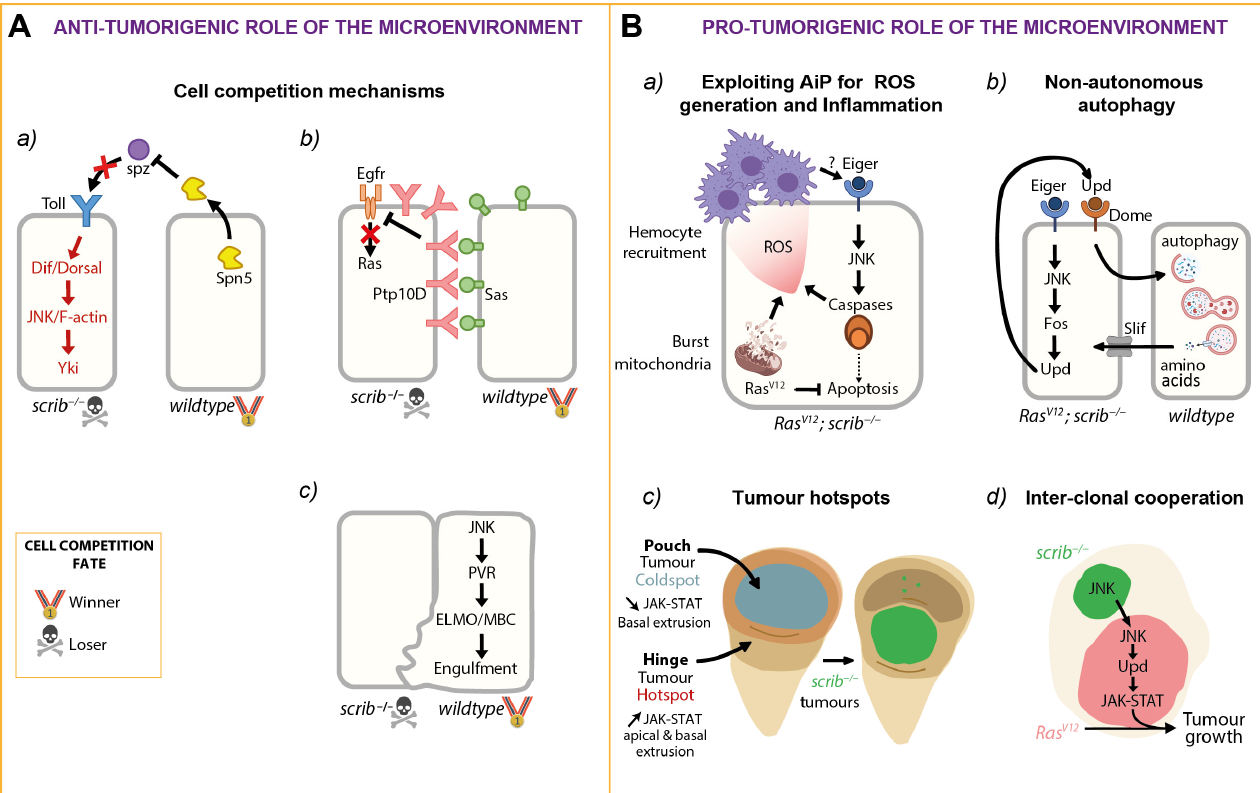
Figure 3. Local microenvironment interactions can act as suppressors or be exploited for tumor growth. ( A ) Anti-tumorigenic role of the microenvironment. scrib − / − tumors are actively eliminated by the neighboring cells through cell competition. Several mechanisms are put in place by the winner cells, the microenvironment, to restrict the growth and remove the loser cells, the scrib − / − tumors. ( a ) The expression of an inhibitor of the toll ligand Spz, Spn5, is critical in the microenvironment to maintain the loser status of scrib − / − tumors. Upon non-autonomous loss of spn5, Toll signaling, together with JNK and high F-actin levels, can elevate yki activity, an inducer of the winner status (shown in red). ( b ) Upon tumorigenesis, wt cells communicate with the tumor cells through the Sas-Ptp10D signaling axis to inhibit Egfr-Ras signaling, a pathway that can potently cooperate with polarity deficiency for malignancy. ( c ) Activation of JNK in the wt cells activates an engulfment program through PVR-ELMO/MBC which leads to the entosis of the scrib − / − tumors and their death. ( B ) Pro-tumorigenic role of the microenvironment. In a cooperative Ras V12 ; scrib − / − scenario, the microenvironment is exploited to fuel tumor growth. ( a ) Caspase apoptotic induction is inhibited by Ras V12 ; however, apoptotic-independent functions still remain active. Ras V12 ; scrib − / − tumors exploit the mechanism behind apoptosis induced proliferation. Caspases, and potentially impaired mitochondria, can induce high levels of ROS, which triggers hemocyte recruitment. This mounts an inflammatory response that leads to higher JNK levels. ( b ) NAA is induced in the wt cells surrounding Ras V12 ; scrib − / − tumors, through tumor autonomous JNK and the autocrine activation of JAK-STAT through Upd and Dome. Downregulation of the transporter slif in Ras V12 ; dlg − / − showed that these tumors are dependent on exogenous nutrient sources, potentially released from the neighboring wt cells through NAA. ( c ) Areas that are nurturing or hindering for tumor growth, termed tumor “hotspots” and “coldspots”, respectively, have been identified in the wing disc. The tumor hotspot, which is in the wing disc hinge, was found to have high levels of JAK-STAT, a pathway critical for the Ras V12 ; scrib − / − tumor growth, and apical extrusion which promotes tumor cell survival. ( d ) The Ras V12 ; scrib − / − cooperative scenario is not restricted to an intraclonal setting. Neighboring scrib − / − clones to Ras V12 tumors has been found to be sufficient to elevate JNK and JAK-STAT in Ras V12 tumors, and to trigger their large overgrowth and